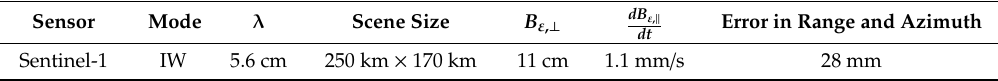
Table 2. Baseline errors inducing one fringe of error in range and